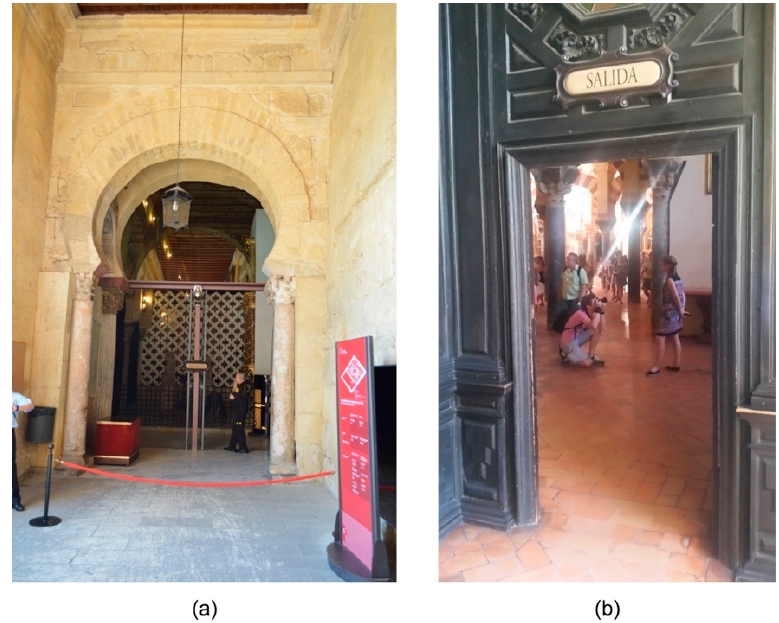
Figure 8. Photographs of ( a ) the entrance to the Mosque-Cathedral and ( b ) the exit.